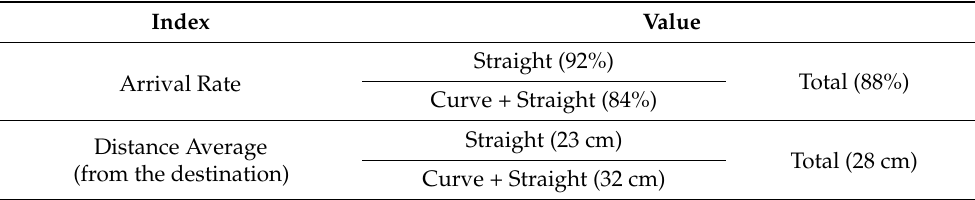
Table 2. Movement performance of the autonomous mobile robot.